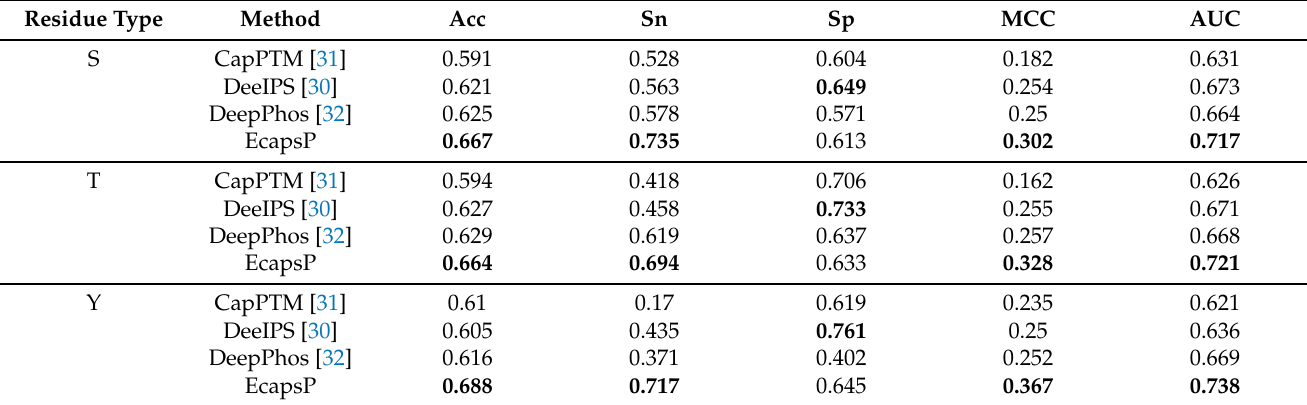
Figure 2. ROC curves of existing tools for phosphorylation site prediction on p-S, p-T, and p-Y independent test sets. ( a ) Serine phosphorylation, ( b ) Threonine phosphorylation, ( c ) Tyrosine phosphorylation. Notes: The ROC curve indicates the balance between sensitivity (or TPR) and specificity (1—FPR). Classifiers that bring the curve closer to the upper left corner indicate better performance. Table 3. Prediction performance of various deep learning models on a benchmark dataset of prokary- otic phosphorylation